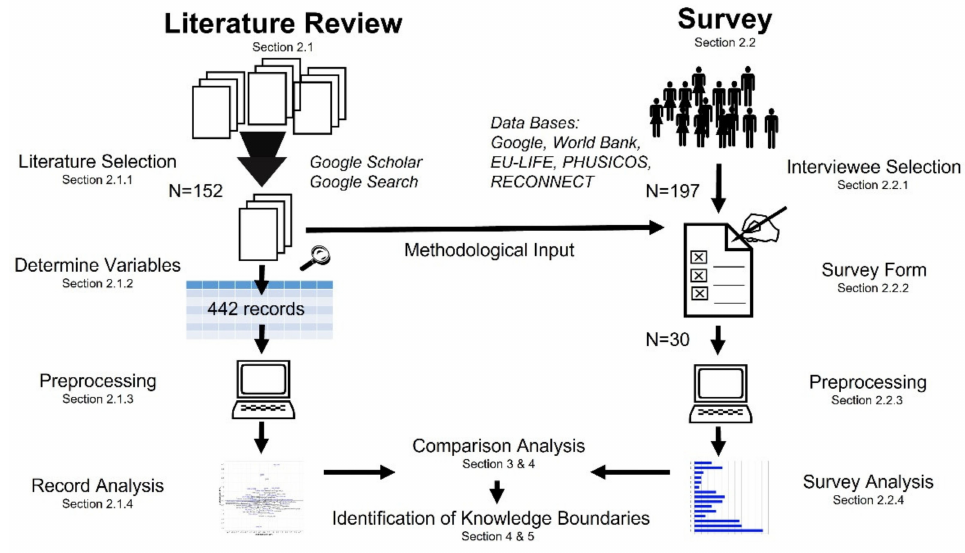
Figure 2. Methodological proceeding.